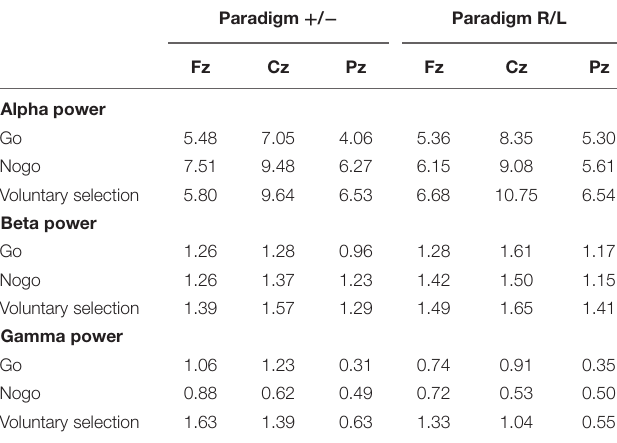
TABLE 2 | Wavelet analysis: mean value of alpha, beta, and gamma power during go , nogo, and voluntary selection in paradigm + / − and paradigm